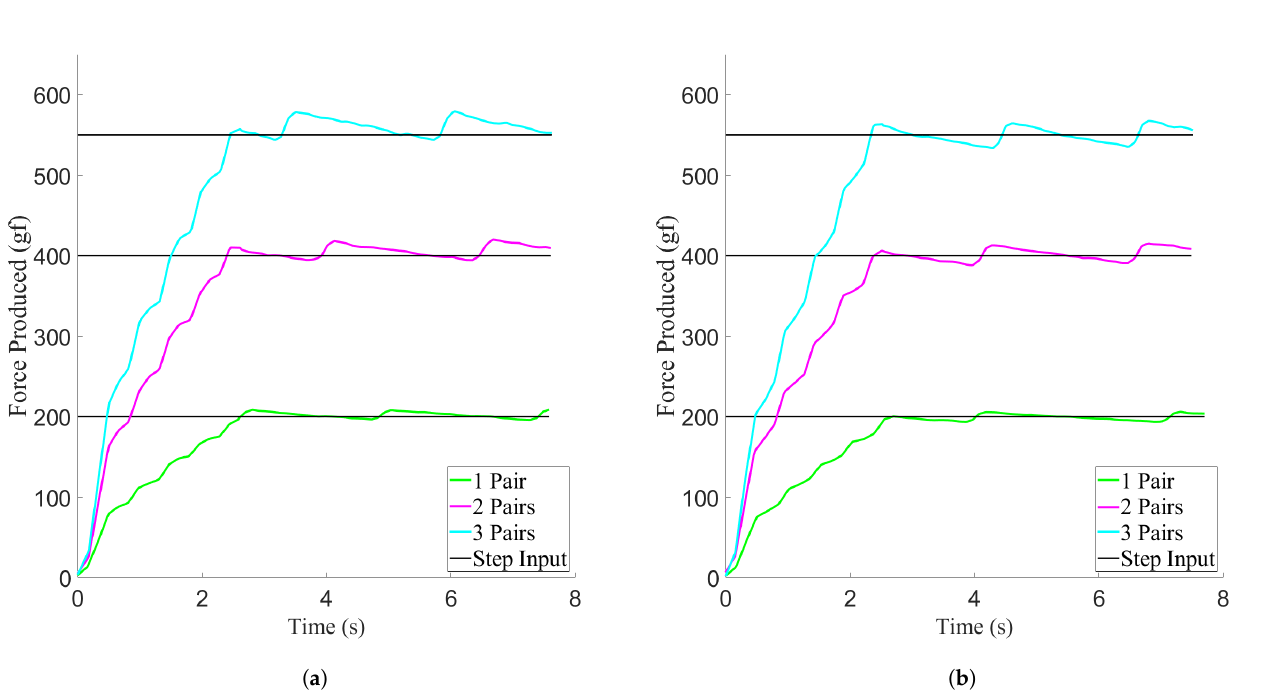
Figure 19. Force responses of the force control implementation experiments, showing data from example trials. For the purpose of clarity, example curves were used due to low variance between trials. ( a ) PID controller force response. ( b ) 2 DOF controller force